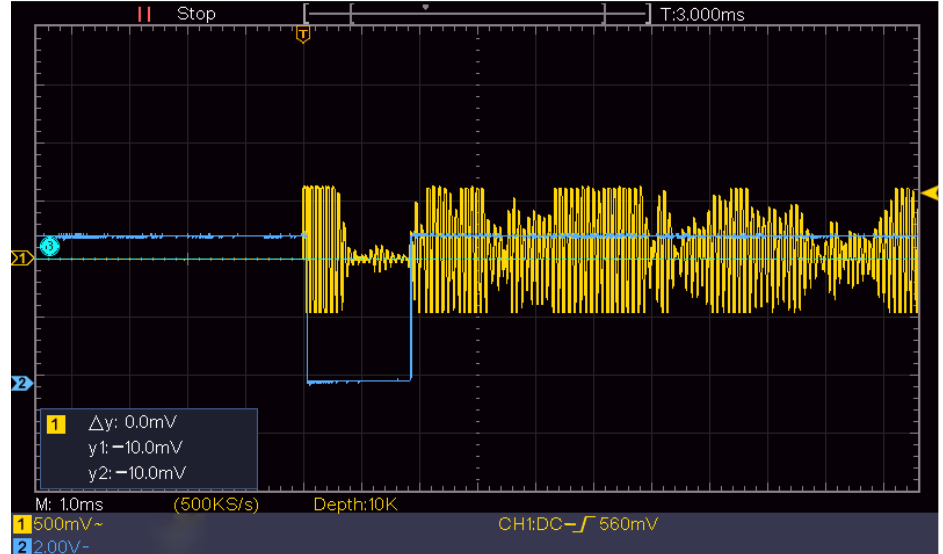
Figure 7. Echo of the probe at 1300 mm recorded by an oscilloscope.